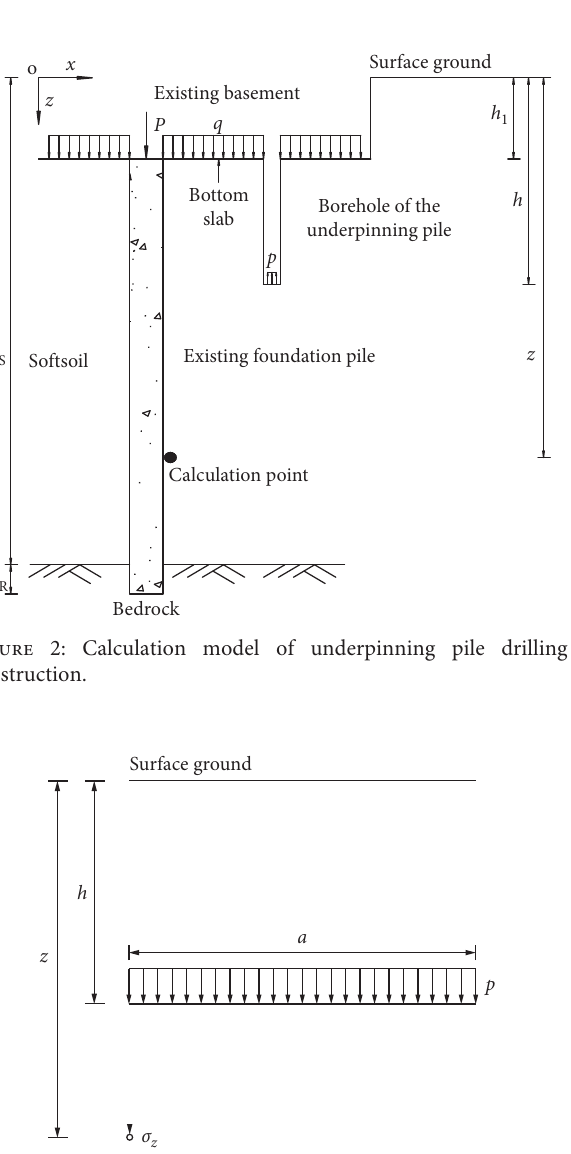
Figure 3: The sketch of Mindlin’s stress solution.